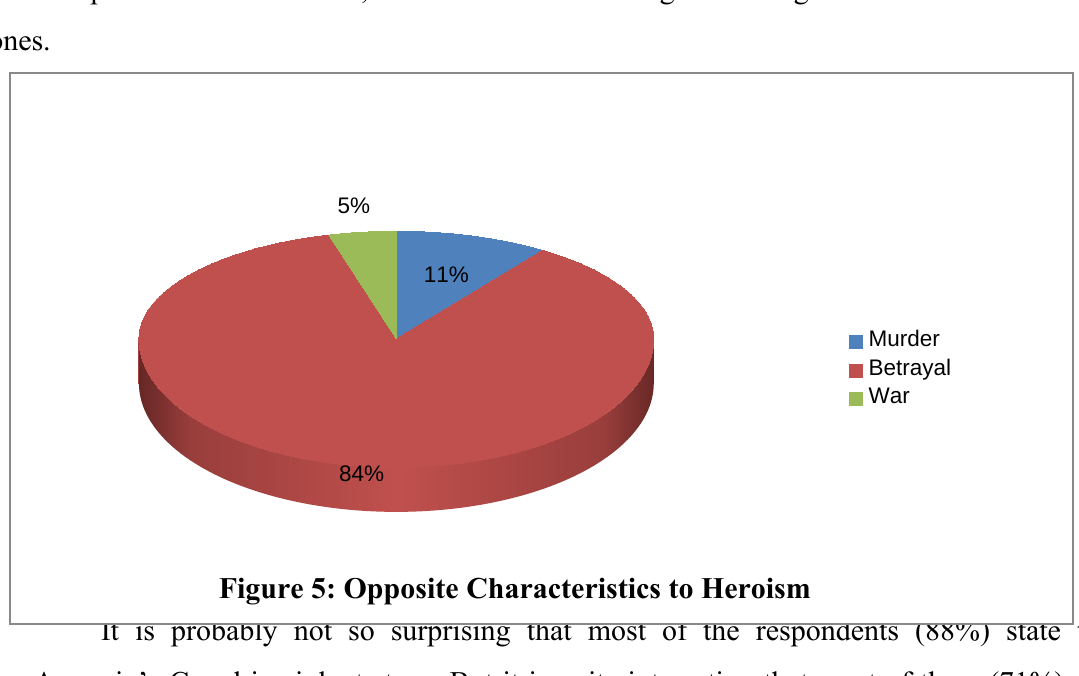
Figure 6: Heroism often Involves